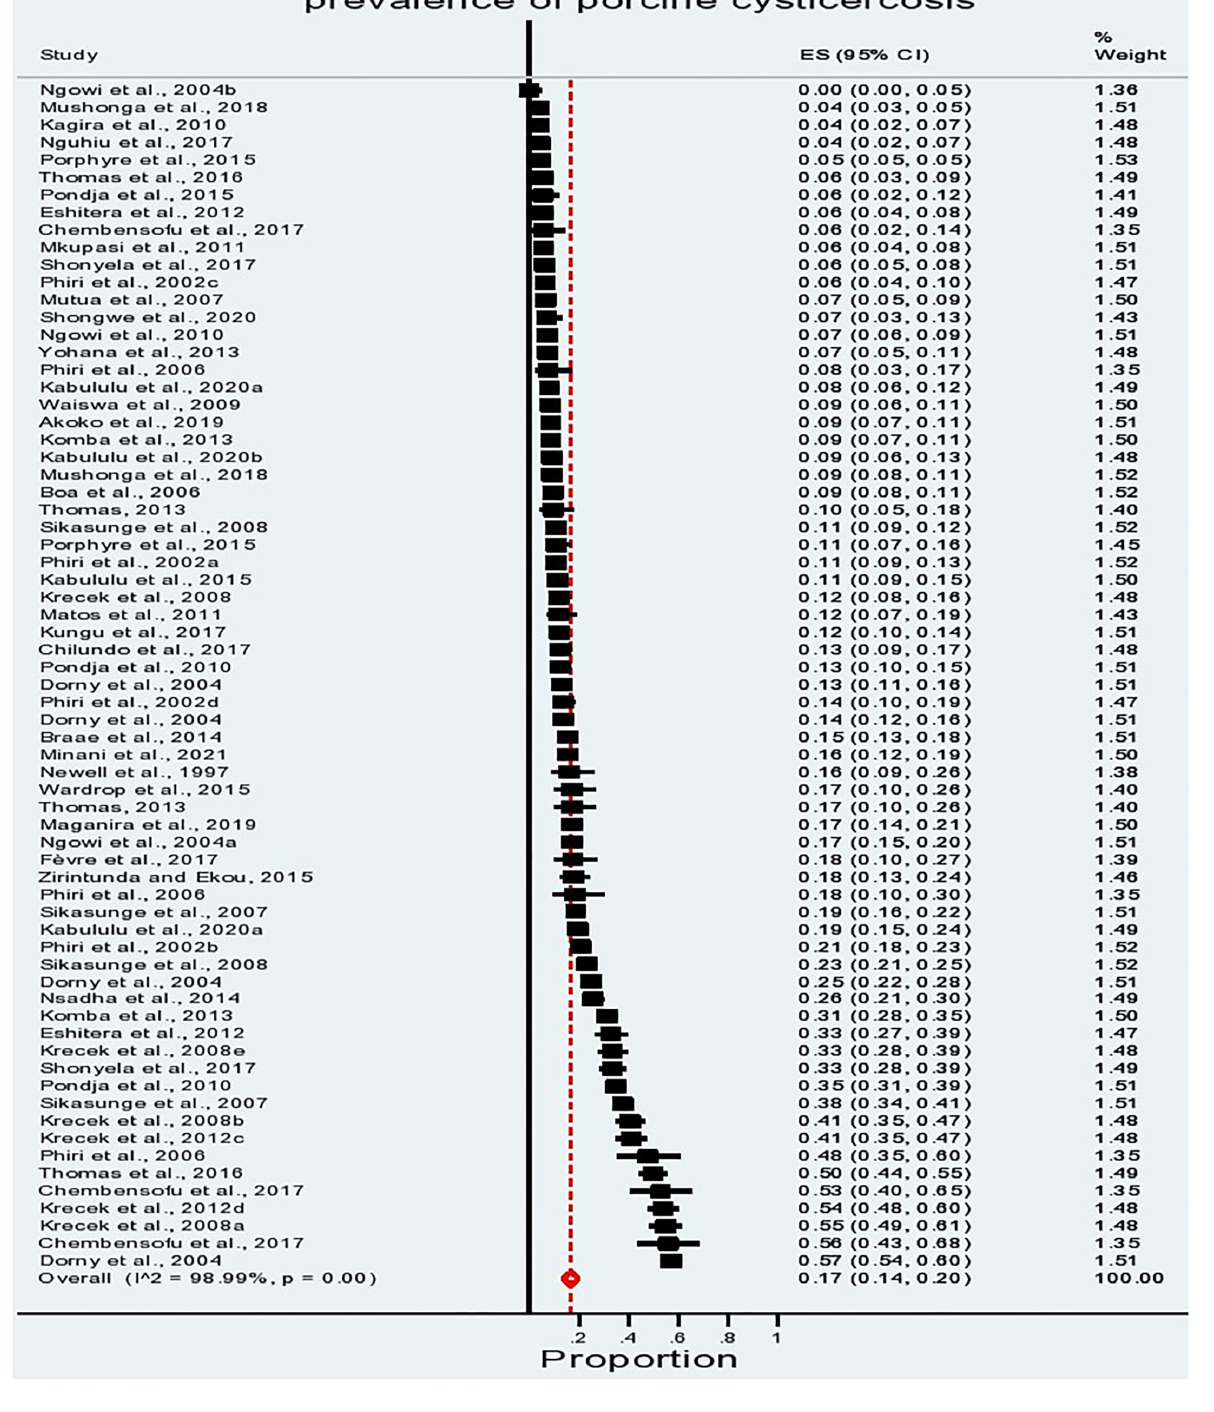
FIGURE 5 | Forest plot showing the studies reporting porcine cysticercosis in the ESA region. The box shows the weight and estimate of the study; the length of the horizontal lines indicates the 95% CI; the vertical broken red line indicates the pooled estimate; the diamond-shaped box at the bottom represents the 95% CI; the solid line indicates the point of null